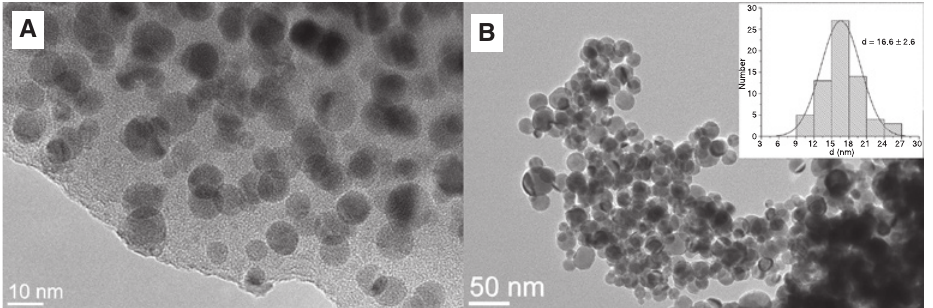
Figure 13: TEM micrographs serve as a good base for size evaluation of prepared particles. (A) Typical TEM images of magnetic particles of sample Ni Cu embedded in a silica matrix and (B) bare alloy particles and the corresponding histogram. Reproduced with permission 67.5 32.5 from Elsevier: Journal of Alloys and Compounds